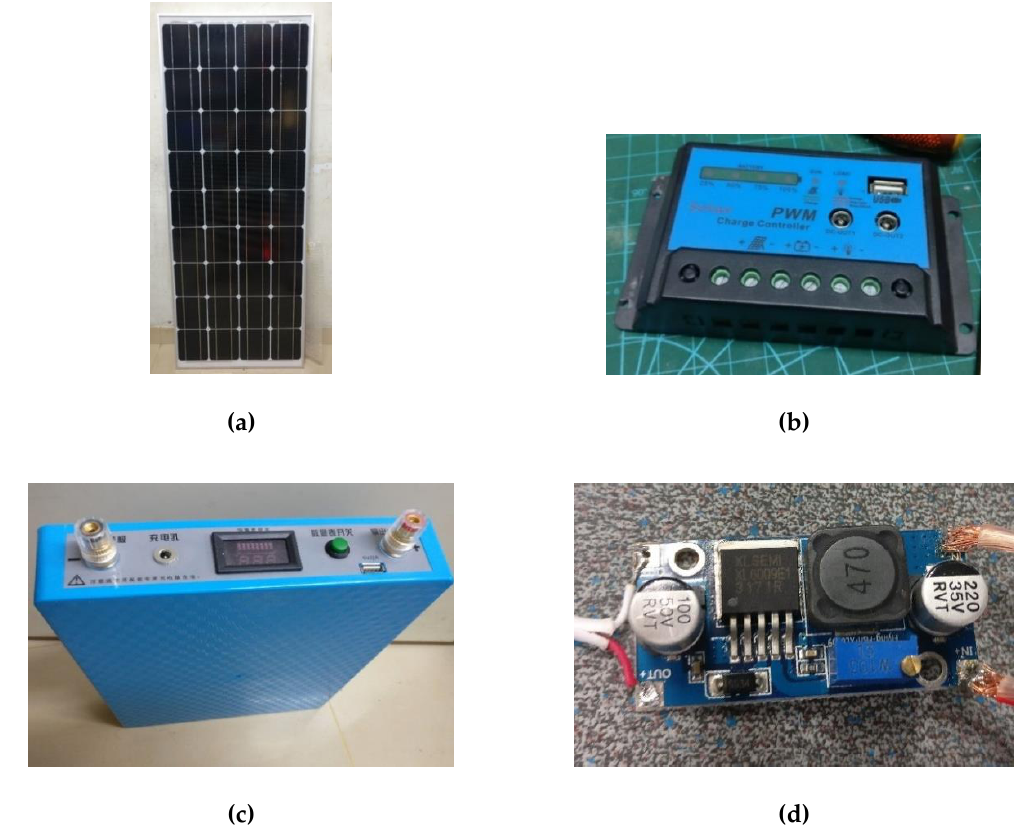
Figure 3. Components in solar module. ( a ) The solar panel that provides the electricity to the system. ( b ) The pulse width modulation (PWM) solar controller that converts the electricity to the system. ( c ) The 720 Wh battery. ( d ) The XL6009E1 DC boost